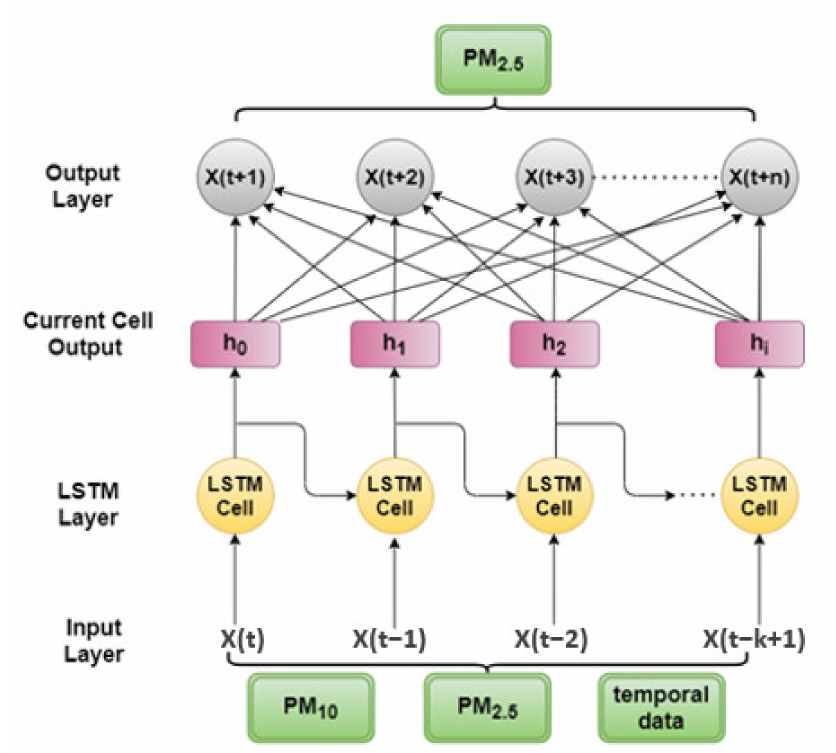
Figure 3. Long short-term memory networks (LSTM)